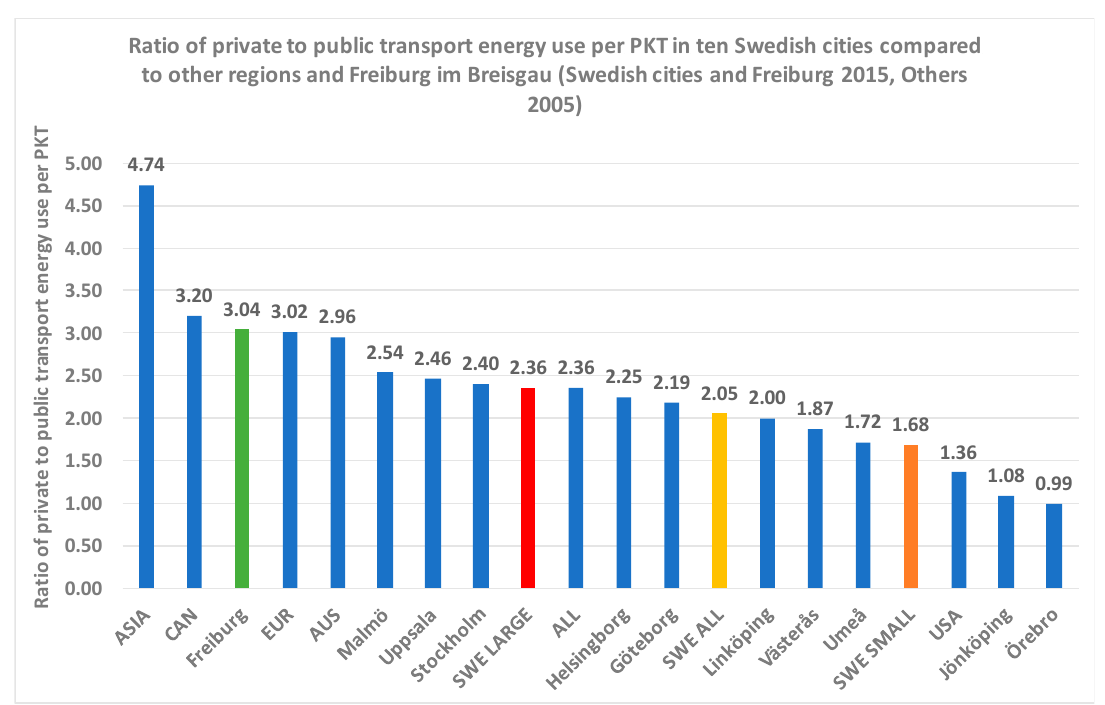
Figure 6. Ratio of private to public transport energy use per PKT in ten Swedish cities (2015); Freiburg (2015); and American, Australian, Canadian, European and Asian cities (2005–2006).